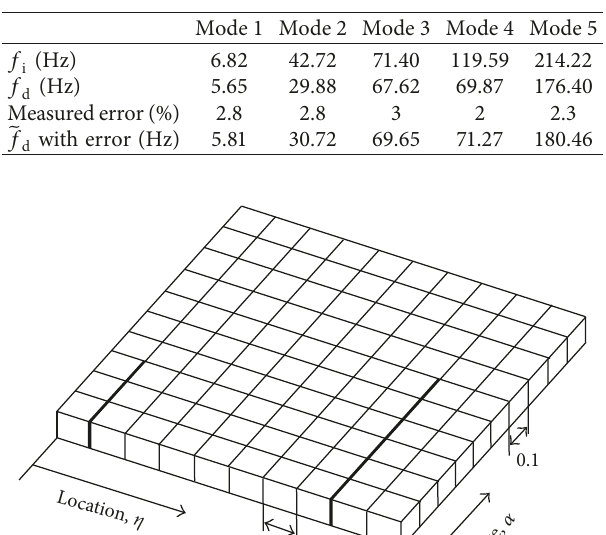
Table 2: Frequency data collected for an intact and multicracked Euler–Bernoulli [1386] laminated composite beam.